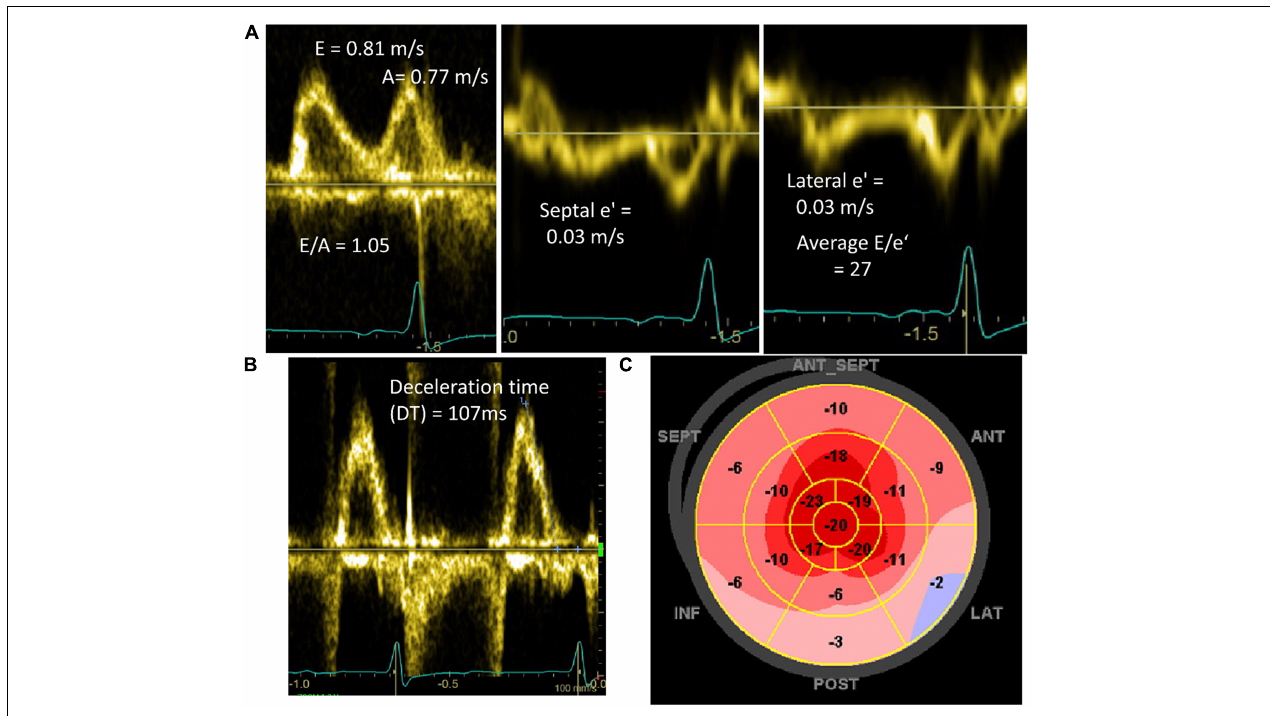
FIGURE 4 | Doppler and longitudinal strain abnormalities in patients diagnosed with cardiac amyloidosis. (A) Mitral inflow and mitral annular tissue Doppler showing pseudonormal diastolic filling (Grade 2) and high E/e (cid:48) signaling elevated left atrial pressures. (B) Mitral inflow pulse wave Doppler of patient in atrial fibrillation demonstrating short deceleration time (DT) (normal 130–220 ms). (C) Peak systolic longitudinal strain map demonstrating reduced longitudinal strain in basal and mid ventricular segments with relative apical